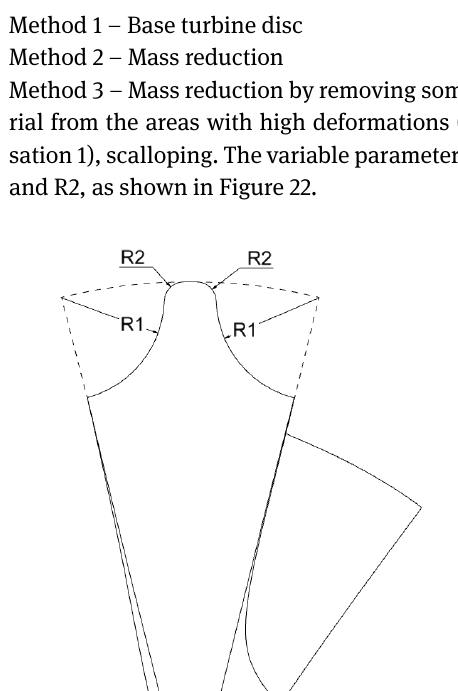
Figure 23: Additional variable parameters used during optimisation using method 4